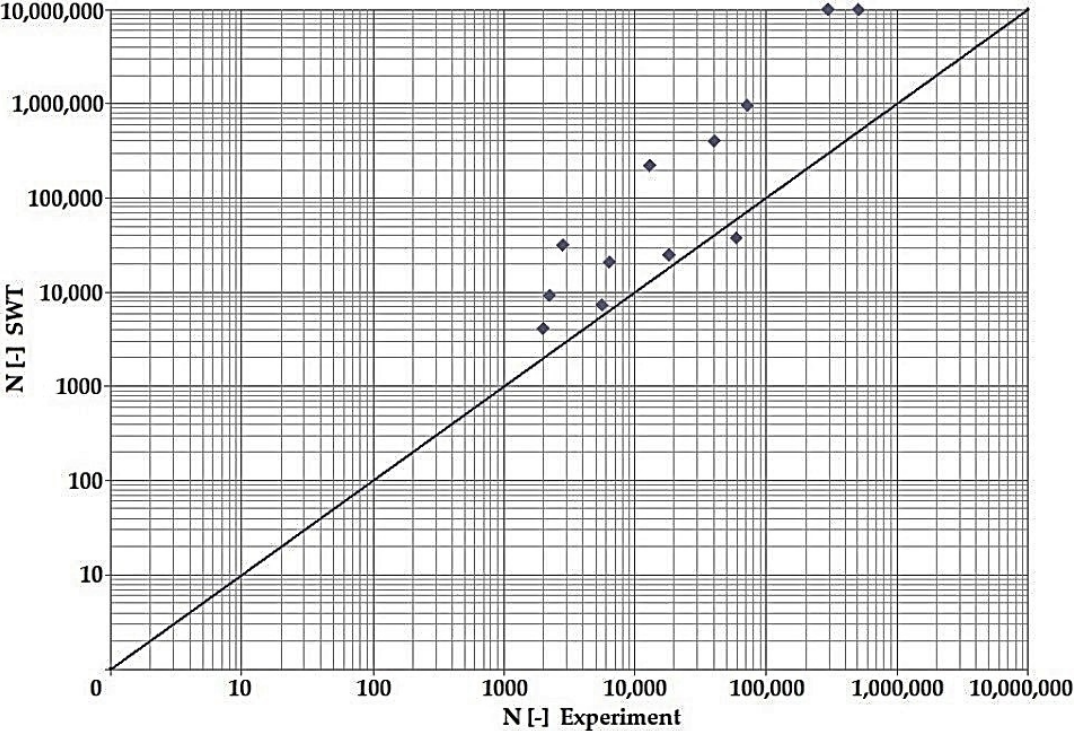
Figure 23. Dependence of theoretical and experimentally obtained number of cycles, SWT vs. experiment, phase shift 0°.